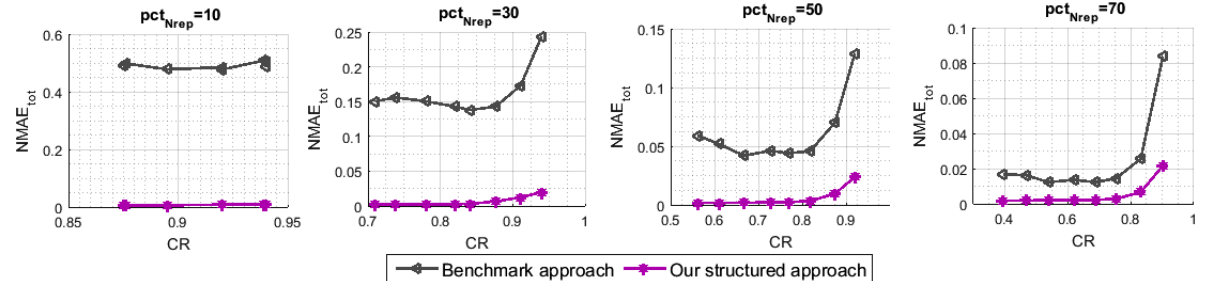
Figure 6. NMAE tot for the proposed technique and for the